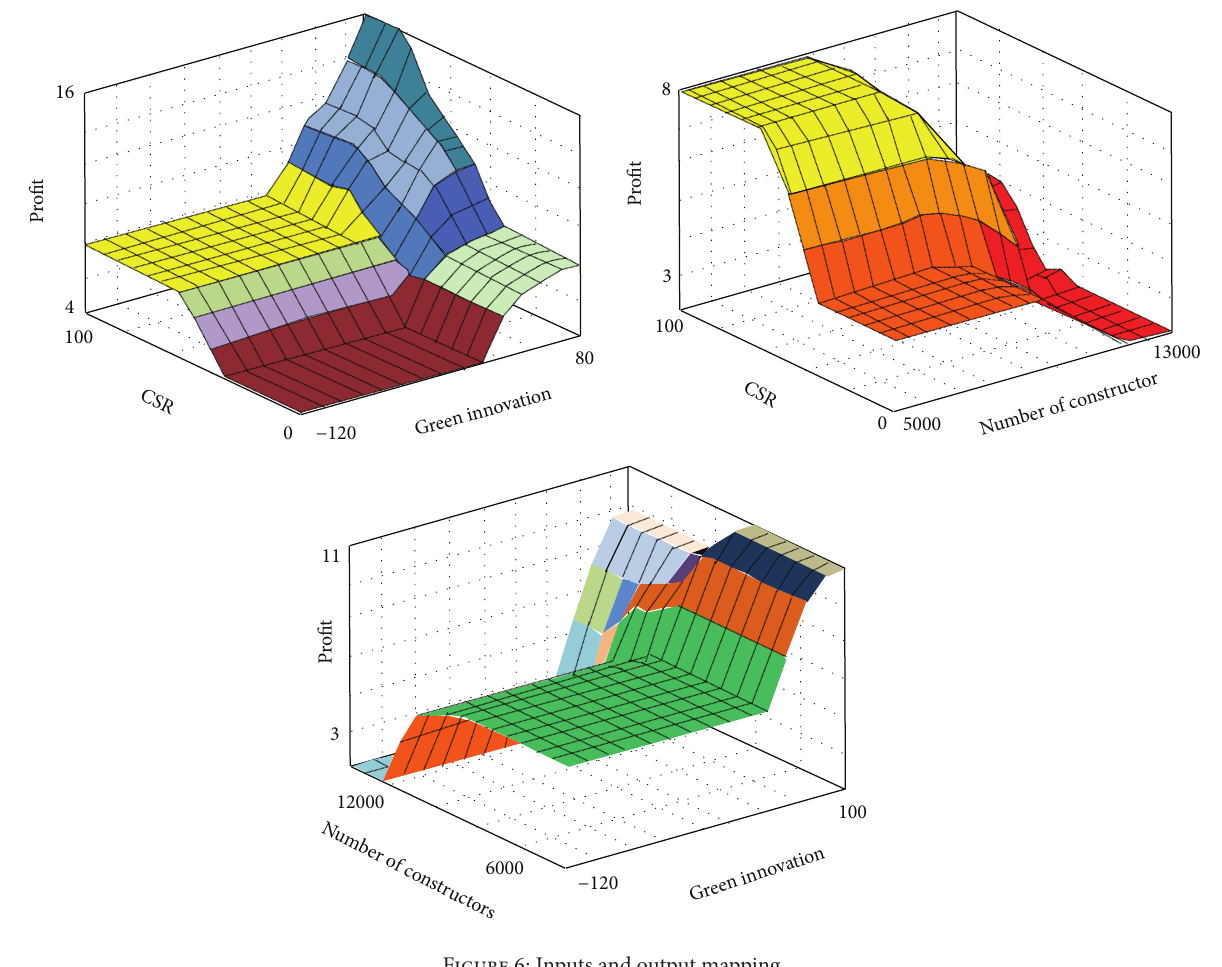
Figure 6: Inputs and output